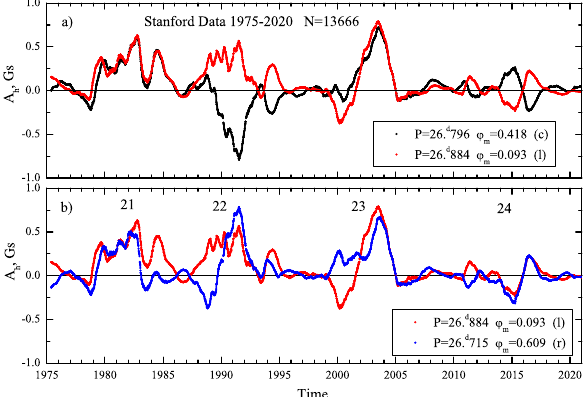
Figure 12. Changes in oscillation amplitudes with time for the right triplet of peaks from Figure 9a: a) for the central (black) and left (red) components, b) for the left (red) and right (blue)